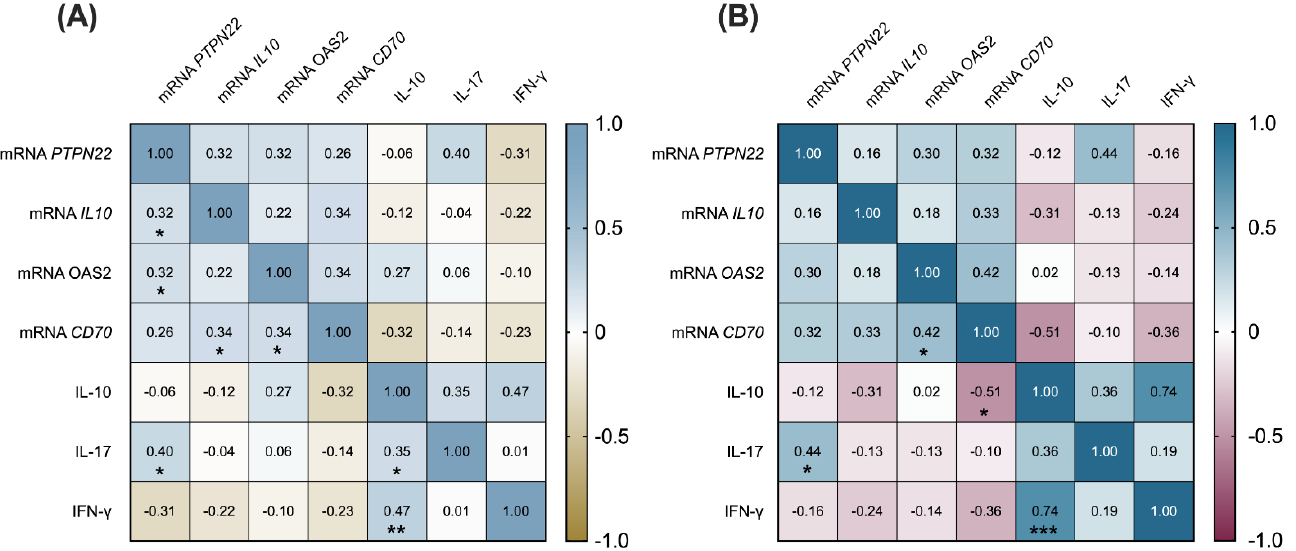
Figure 3. Correlations between PTPN22 , IL10 , OAS2 , and CD70 gene expression and IL-10, IL-17, and IFN- γ cytokine levels in SLE patients. ( A ) Correlation matrix showing correlation coefficient values considering all SLE patients; ( B ) Correlation matrix showing correlation coefficient values considering only active SLE patients (Mex-SLEDAI score > 2, n = 25). Linear correlation coefficients were determined using Spearman’s correlation test. * p < 0.05, ** p < 0.01, *** p < 0.001.